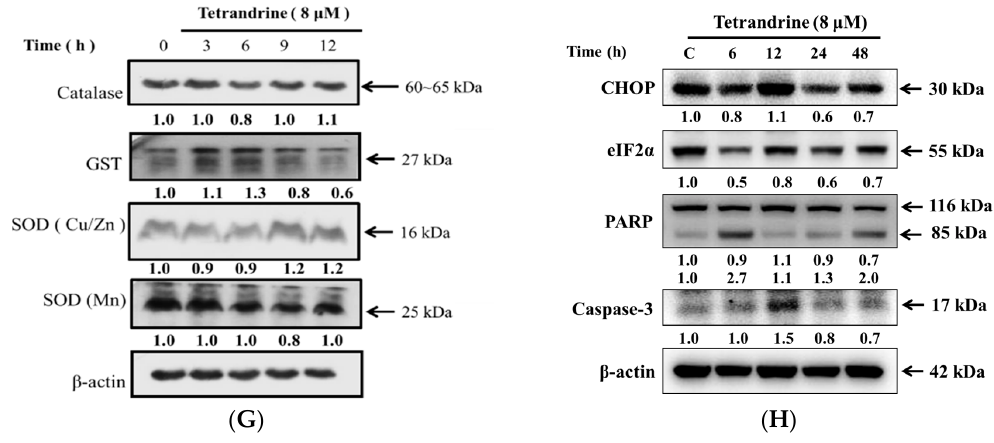
Figure 5. TET affects apoptosis associated protein expression in NPC-TW 076 cells. Cells were treated with 8 μ M of TET for 0, 6, 12, 24 and 48 h and then total proteins were quantitated and apoptosis associated proteins were measured by western blotting as described in Materials and Methods.